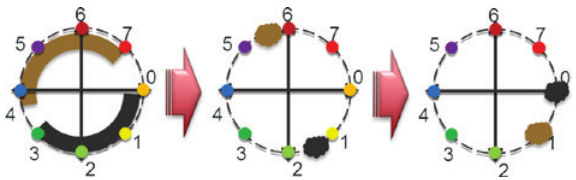
Figure 17: Loss of carry context during modular add.